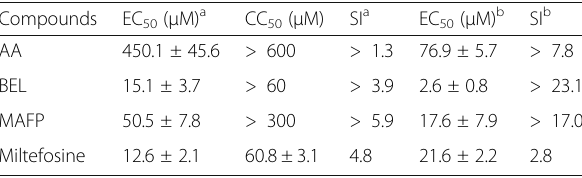
Table 1 Activity of PLA 2 inhibitors against promastigote, amastigote and peritoneal macrophages from BALB/c mice Compounds